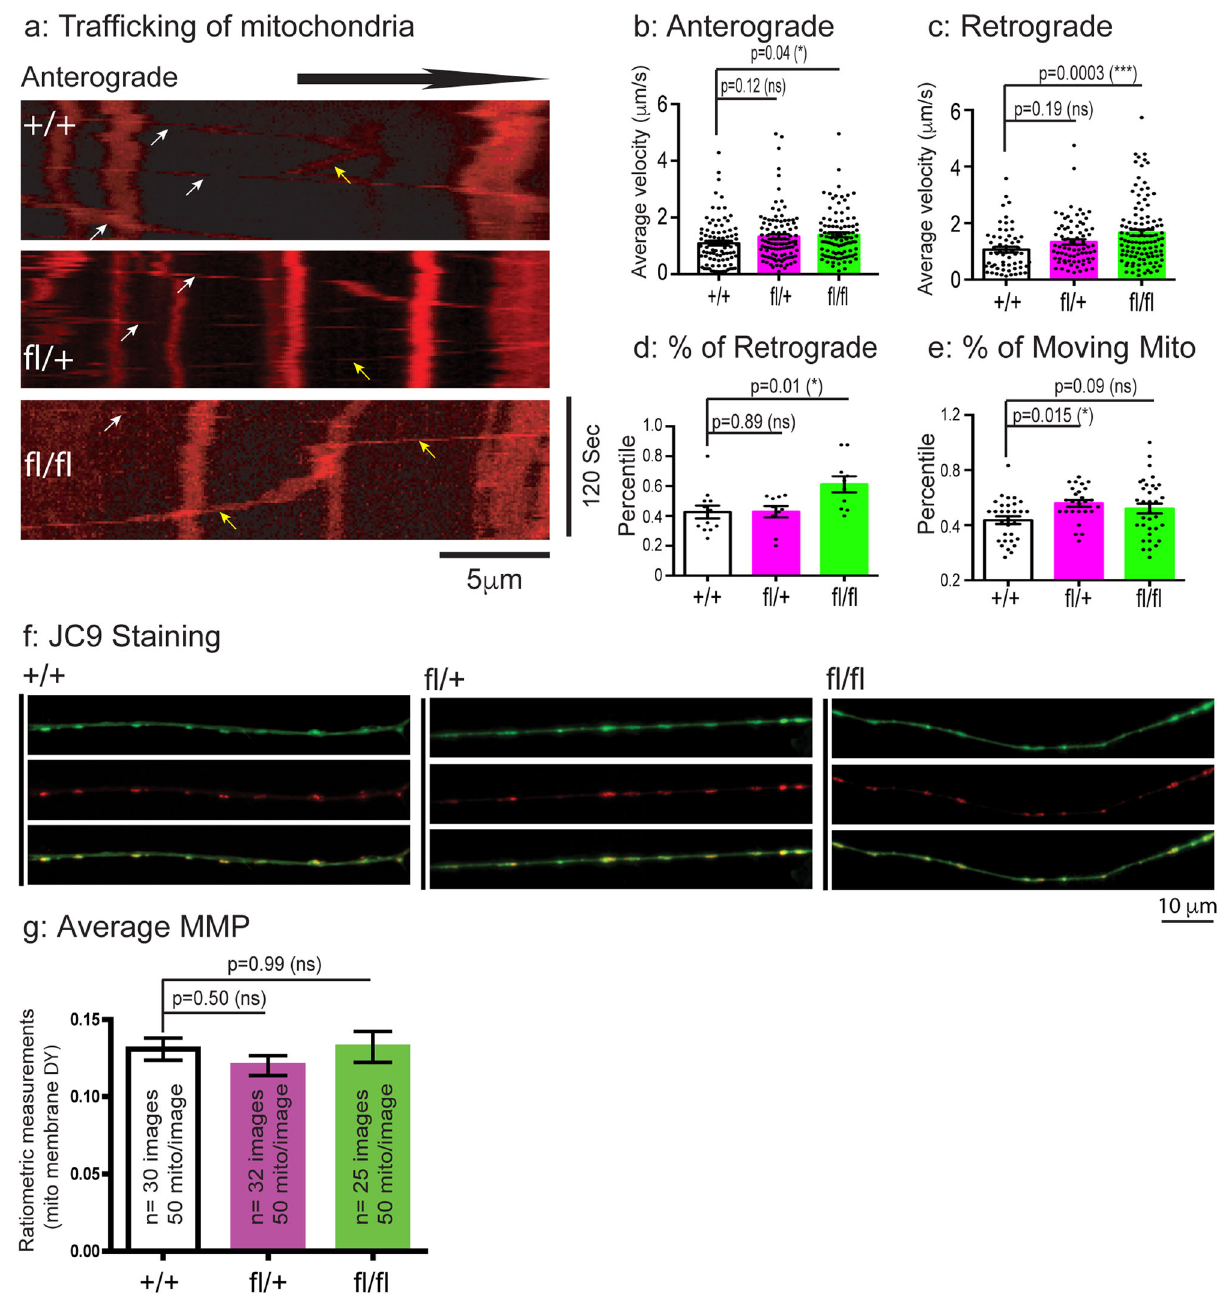
Fig. 5 Axonal motility of mitochondria is altered in fl / fl E18 DRG sensory neurons of the CMT2B mutant mice. E18 DRG sensory neurons from + / + , fl / + , fl / fl embryos were dissected, cultured and labeled with Mito Tracker at DIV4-7 as in Fig. 4. Time-lapsed images of axonal mitochondria were captured by live imaging microscopy. The image series were used to generate kymographs in Image J to quantitate axonal mitochondrial motility. a : Representative kymographs of + / + , fl / + and fl / fl . White arrows indicate traf fi cking in anterograde direction, yellow arrows indicate traf fi cking in retrograde direction. Average velocities of axonal mitochondria moving in the anterograde (The numbers of mitochondria were analyzed are: n = 88 for + / + , n = 103 for fl / + , n = 96 for fl / fl ) ( b ) and retrograde (The numbers of mitochondria were analyzed are: n = 59 for + / + , n = 76 for fl / + , n = 109 for fl / fl ) ( c ) direction. d : % of retrogradely moving mitochondria (The numbers of axons were analyzed are: n = 12 for + / + , n = 10 for fl / + , n = 10 for fl / fl ). e : % of total moving mitochondria (The numbers of axons were analyzed are: n = 31 for + / + , n = 26 for fl / + , n = 34 for fl / fl ). We also performed JC9 staining to measure MMP by ratiometric analysis. f : representative images of JC9 staining of mitochondria of DRG axons of + / + , fl / + , fl / fl . The green channel and the red channel images as well as the merged images are shown. g : Ratiometric measurements of MMP in + / + , fl / + , fl / fl . Results are shown as mean ± SEM. The numbers of axons analyzed are: n = 12 for + / + , n = 10 for fl / + , n = 10 for fl / fl . The numbers of mitochondria are shown in the graphs. Signi fi cance analysis was carried out using Prism. Statistical signi fi cances were calculated by One-Way ANOVA. n.s = non signi fi cance. All p values are shown in the